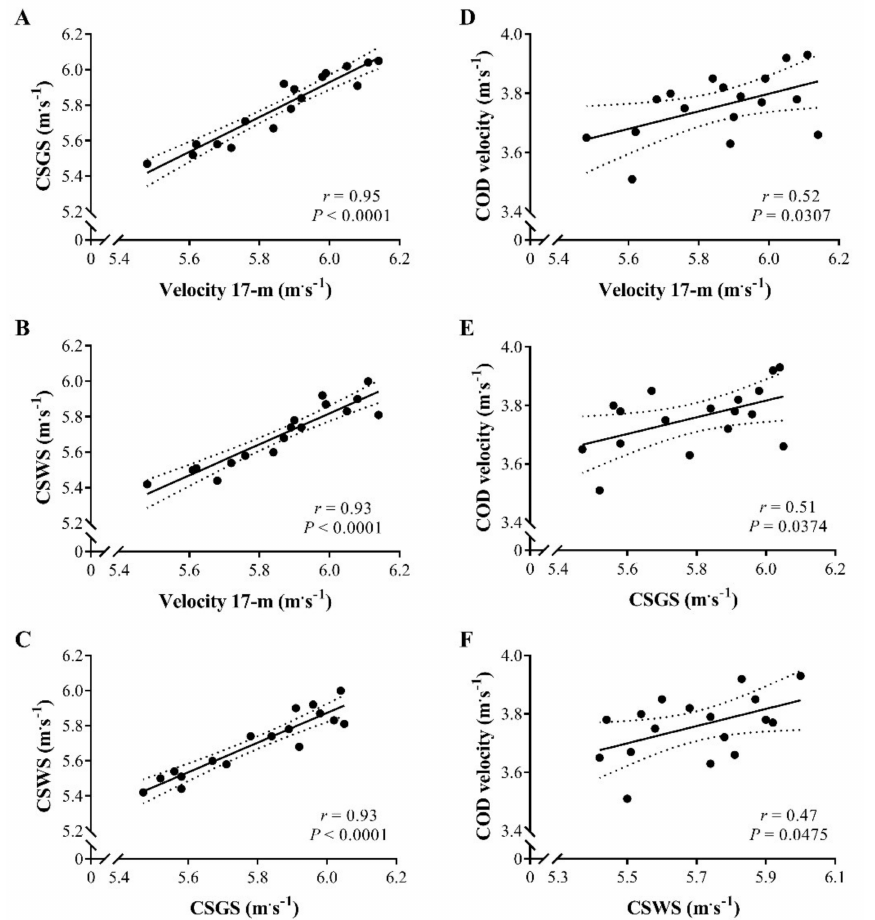
Figure 2. ( A – F ) Linear regressions between 17 m linear sprint velocity, curve sprint velocity for the good and weak sides (CSGS and CSWS, respectively), and change of direction (COD)